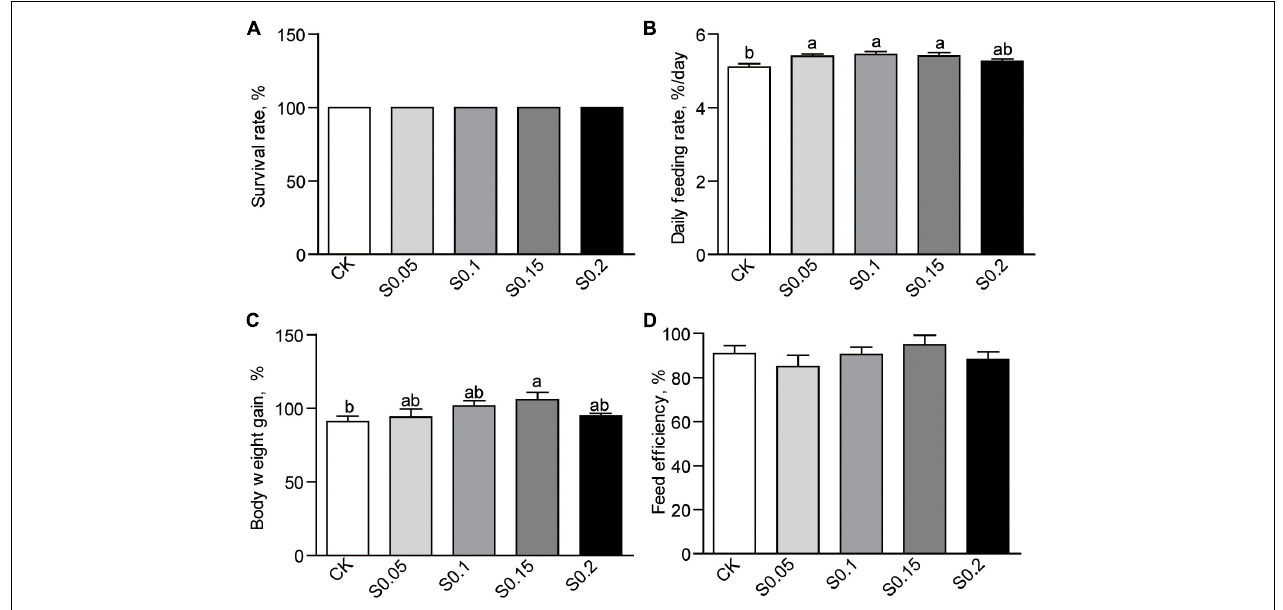
FIGURE 1 | (A) Survival, (B) feed intake, (C) body weight gain, and (D) feed efficiency in zebrafish fed the CK or S0.15 diet for 4 weeks. Values are means ± standard errors of the means (SEMs; n = 4 biological replicates). Means without a common letter are significantly different, p < 0.05. CK, control-check diet; S0.05, S0.1, S0.15, and S0.2, 0.05, 0.1, 0.15, and 0.2% succinate-supplemented